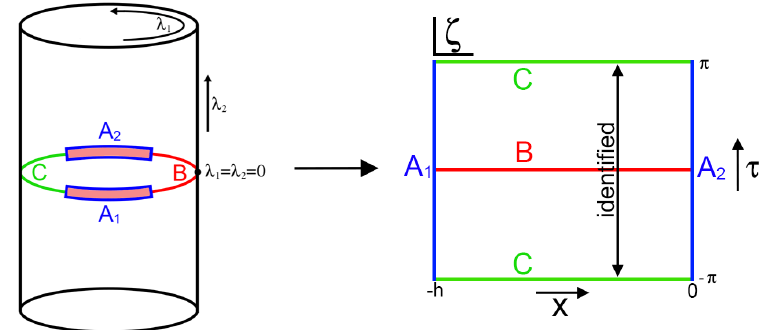
¯ λ coordinates to the finite